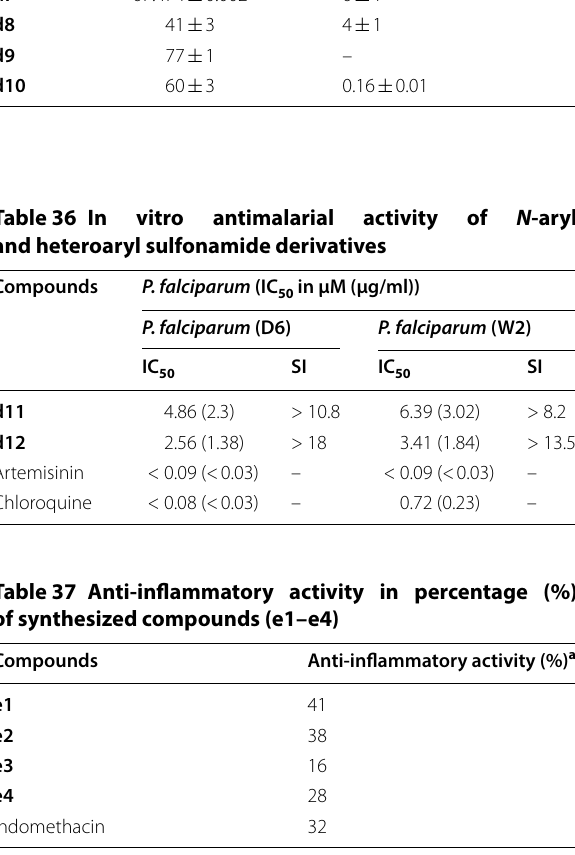
a 100 mg/kg p.o. ( n